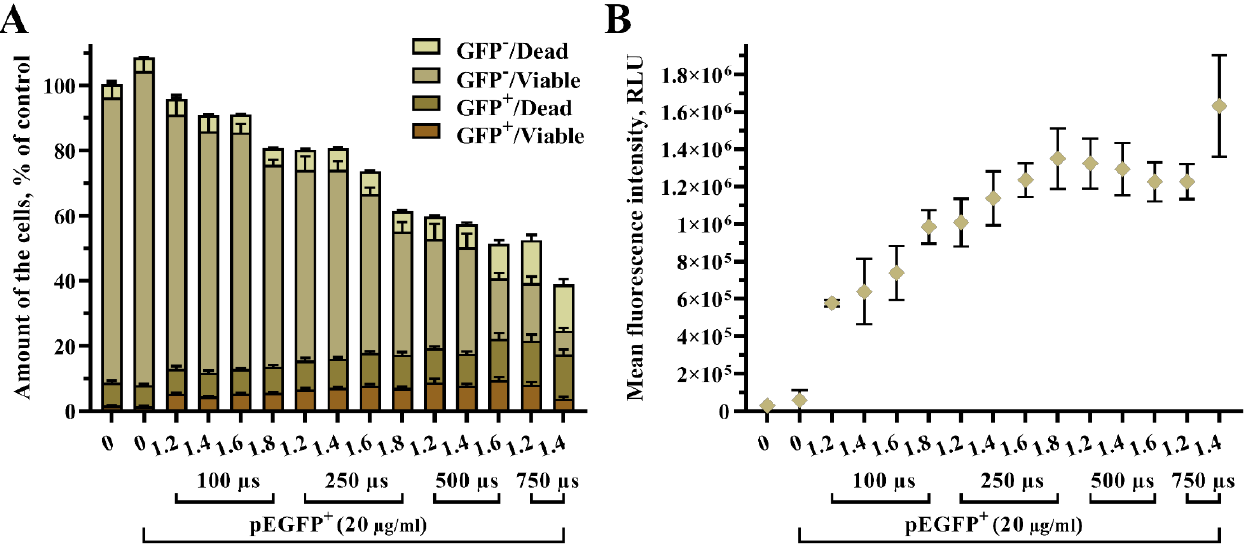
Figure 3. Distribution of UT-7 cells per sample among four groups representing transfected/viable cells denoted as (GFP + /Viable), transfected/dead as (GFP + /Dead), untransfected/Viable as (GFP − /Viable), and untransfected/dead as (GFP − /Dead) shown in stacked bars. The overall cell number in the sample is shown as column height ( A ). The pEGFP fluorescence intensity is represented by a scatter dot plot ( B ). The X-axis depicts pulse strength in kV/cm. The data points are shown as mean ± SD from two independent experiments performed in quadruplicate and were further analyzed using one-way ANOVA with Tukey’s multiple comparisons test. All statistical results are presented in the Supplementary file (Table S1).